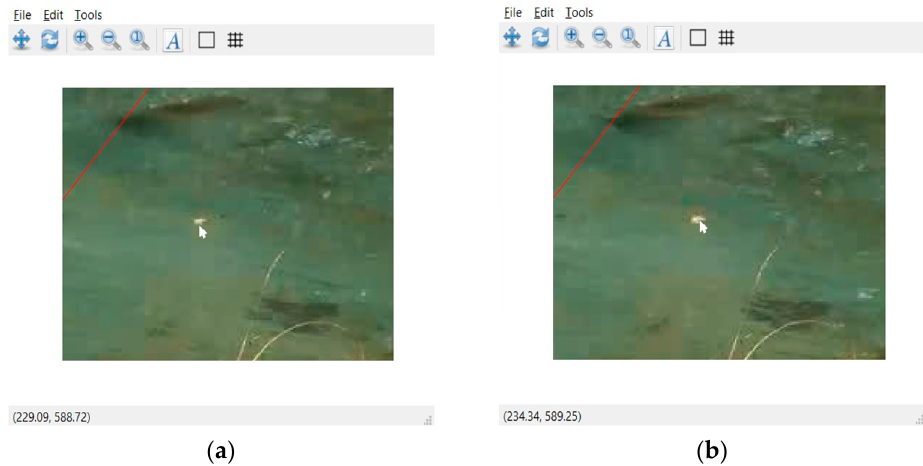
Figure 1. Manual estimation of the surface velocity in Loussios at Atsicholos Bridge. The cursor is placed over the feature (exactly the same point of a leaf), and the row and column pair is obtained: ( a ) frame 200 of the video; ( b ) frame 202 of the video. The frames were processed with GNU Octave.